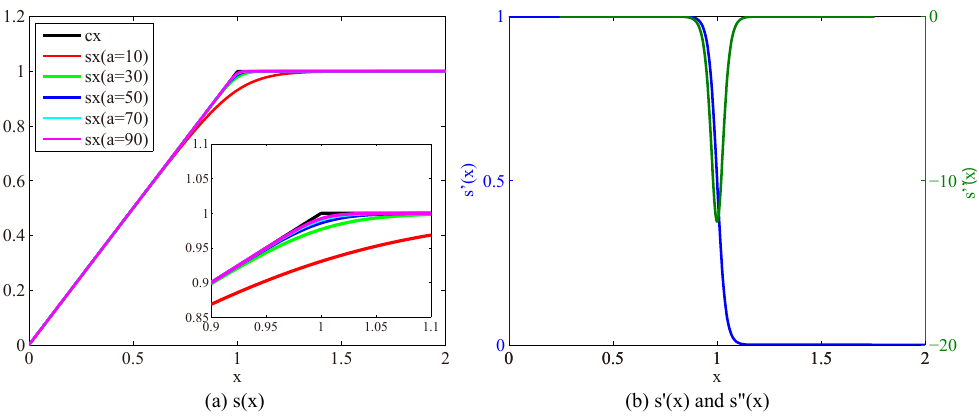
Figure 4. Nonlinear function s ( x ) and its derivatives. ( a ) Nonlinear function s ( x ) with different parameter values of a and ( b ) the first- and second-order derivatives of s ( x ) with parameter a =